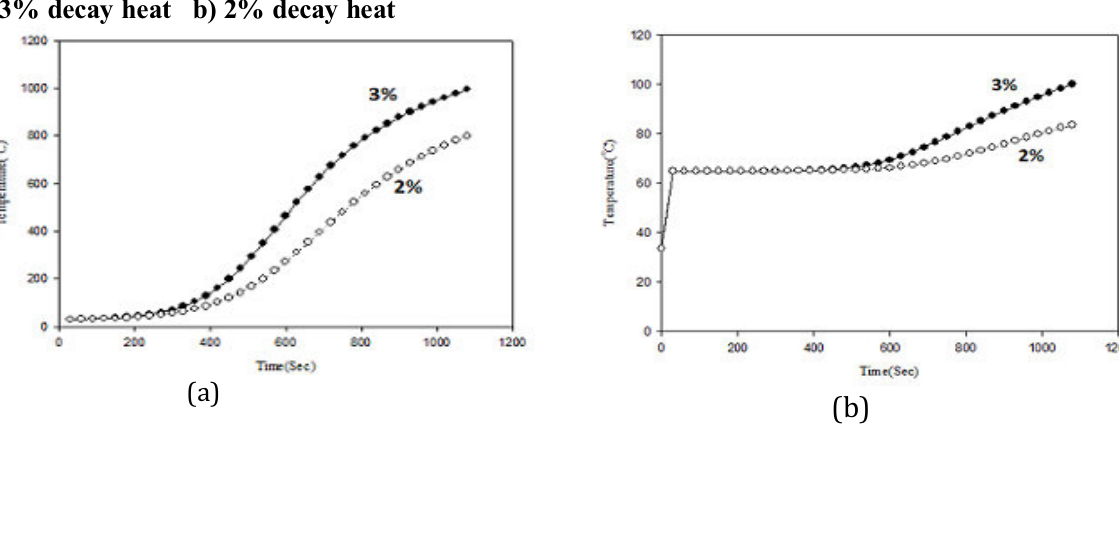
Figure 7.Variation in different components of fuel bundle simulator temperature with time for a)3% decay heat b) 2% decay